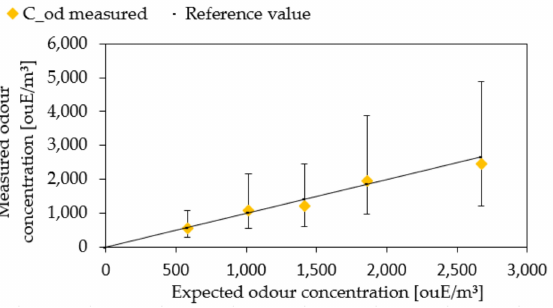
Figure 9. Scatter diagram of between odour concentrations determined using the EN 13752 method and the expected values, due to the generation process at 140 ◦ C (C xOH expressed in ppm of butanol), obtained during the second field